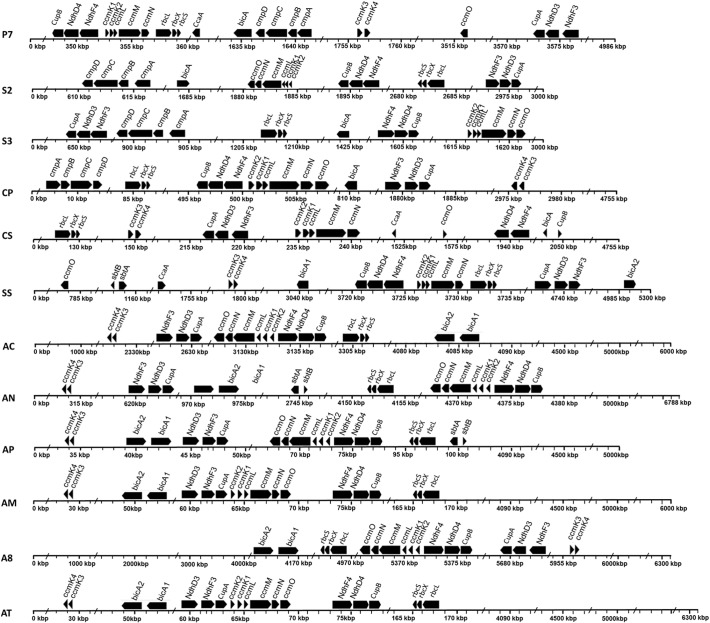
Comparative genomic structure and gene organization of the CCM in all 12 alkaliphilic cyanobacteria. Solid arrow boxes indicate genes and the direction of transcription. The completed genome sequence was available for P7, S2, S3, and CS, while for other strains there is only permanent draft genome information.